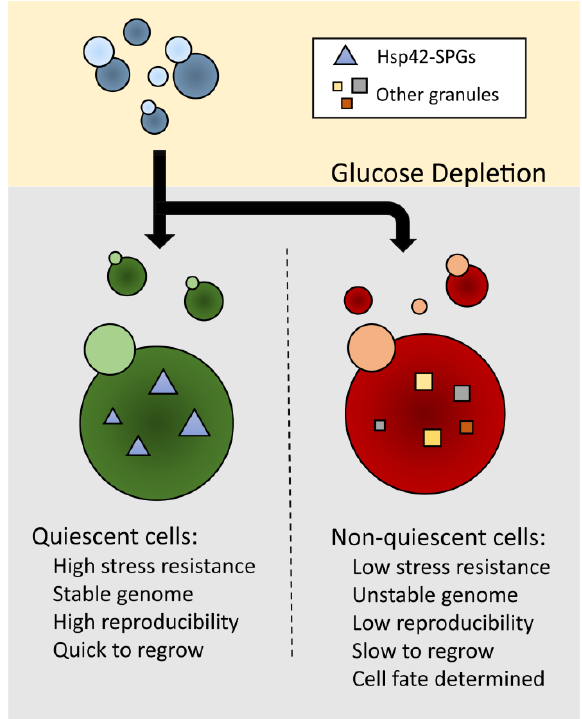
FIGURE 1: Hsp42-associated stationary phase granules (Hsp42- SPGs) confer features for quiescent cells (Q) that are distinct from non-quiescent cells